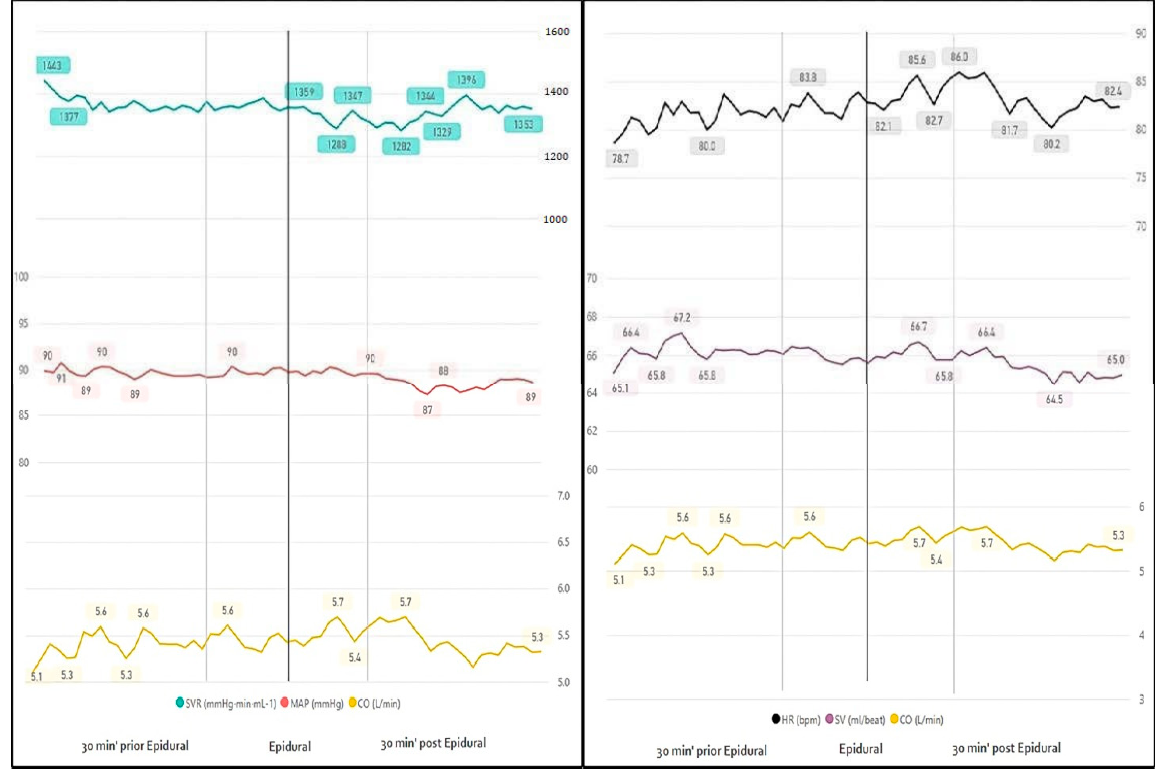
Figure 2. Continuous monitoring 30 min before and after epidural anesthesia. SVR—systemic vascular resistance; MAP—mean arterial blood pressure; p < 0.05 is marked in bold; CO—cardiac output.